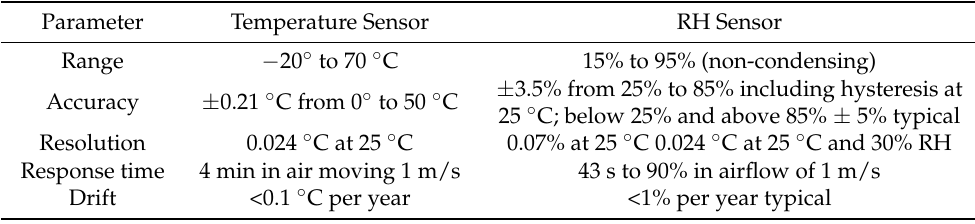
Table 1. Technical specifications of HOBO temp/RH sensors employed in. Parameter